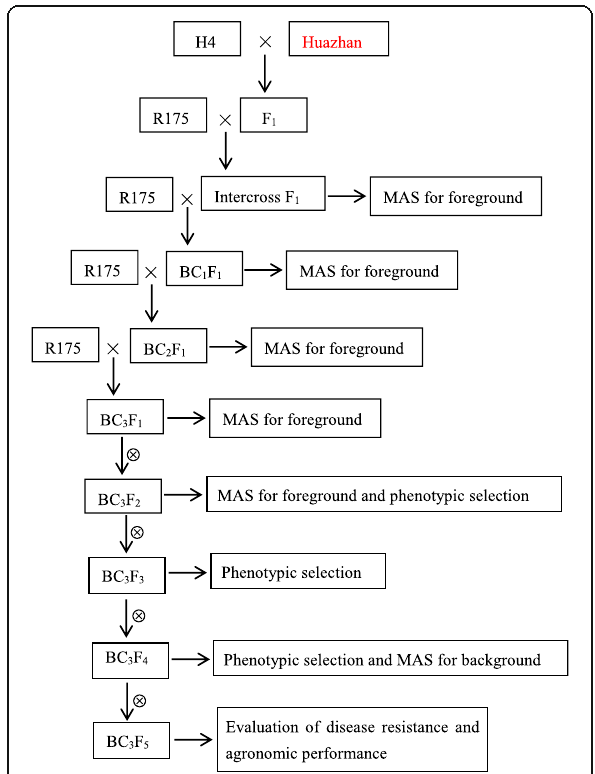
Fig. 1 Schematic work flow of marker-assisted backcross